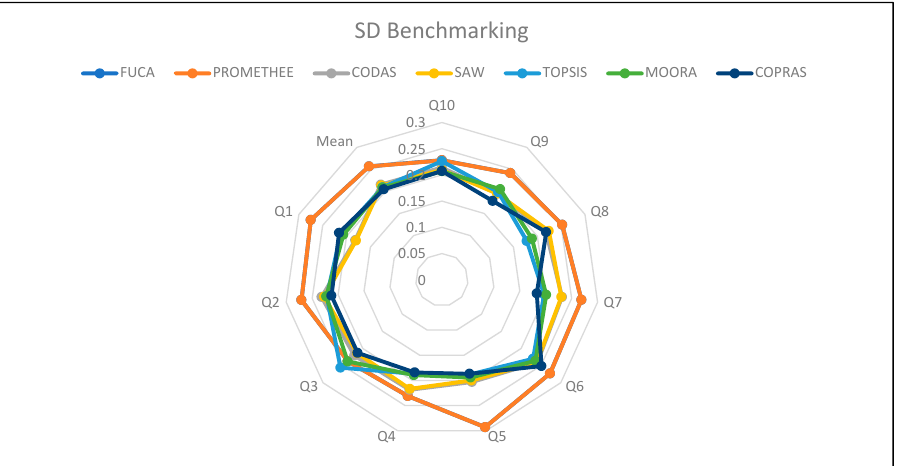
Figure 2 below is the Performance Radar Graph of MCDMs based on SD benchmark. Here it can be better seen that the PROMETHEE&FUCA duo produces a predominantly higher SD.